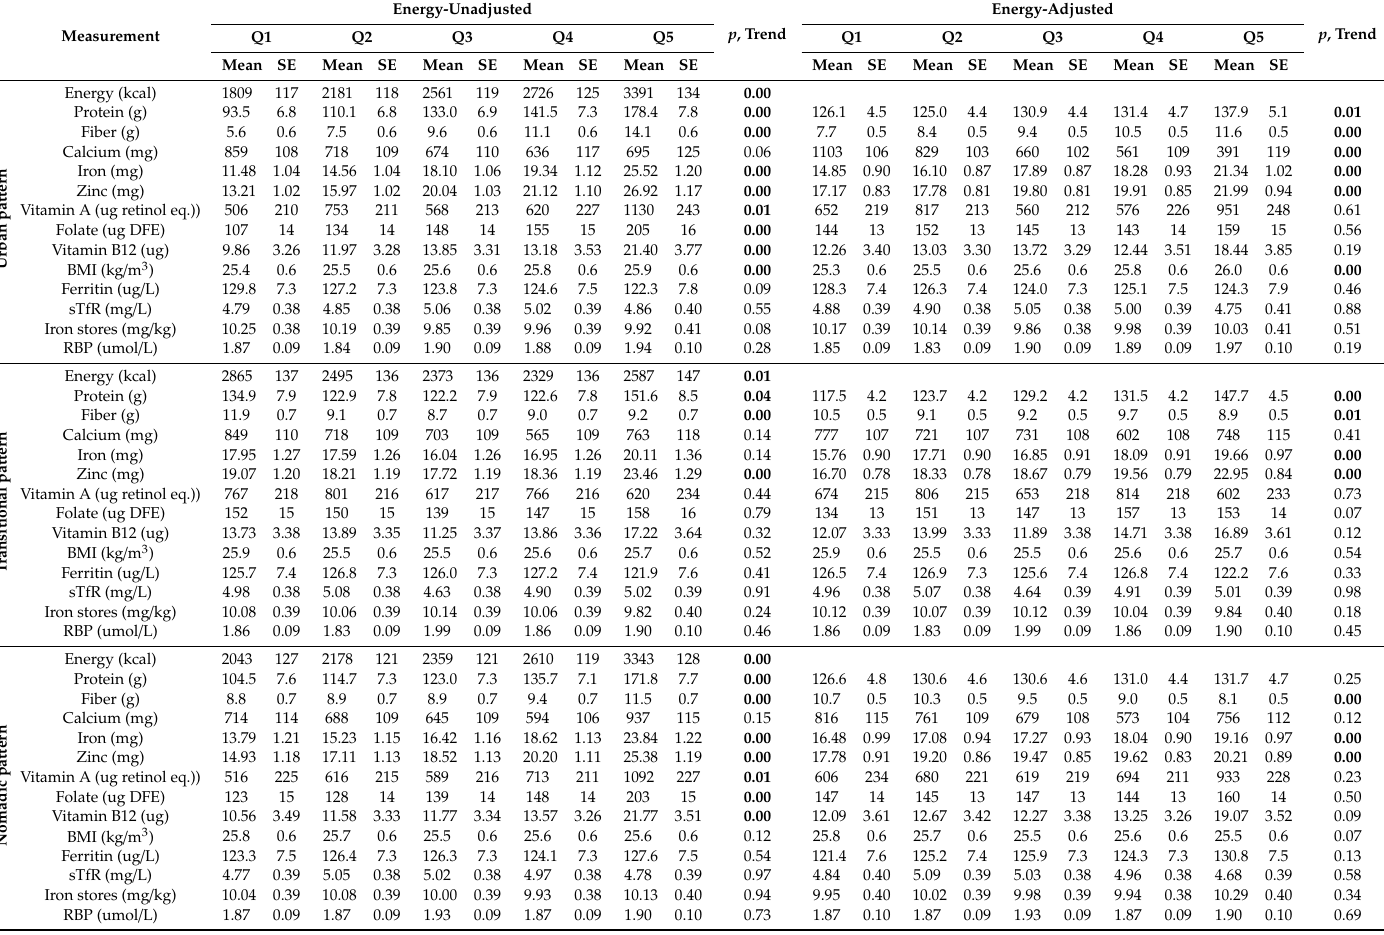
Table 9. Estimated marginal means of selected nutrient intakes and clinical measurements by quintile of diet pattern scores.